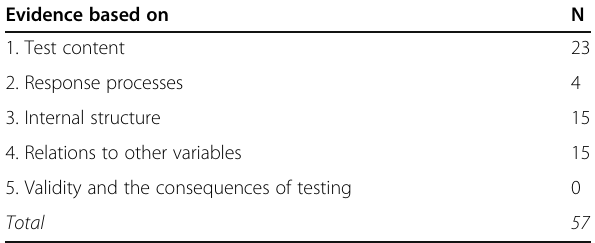
Table 4 Sources of validity evidence reported for all studies Evidence based on